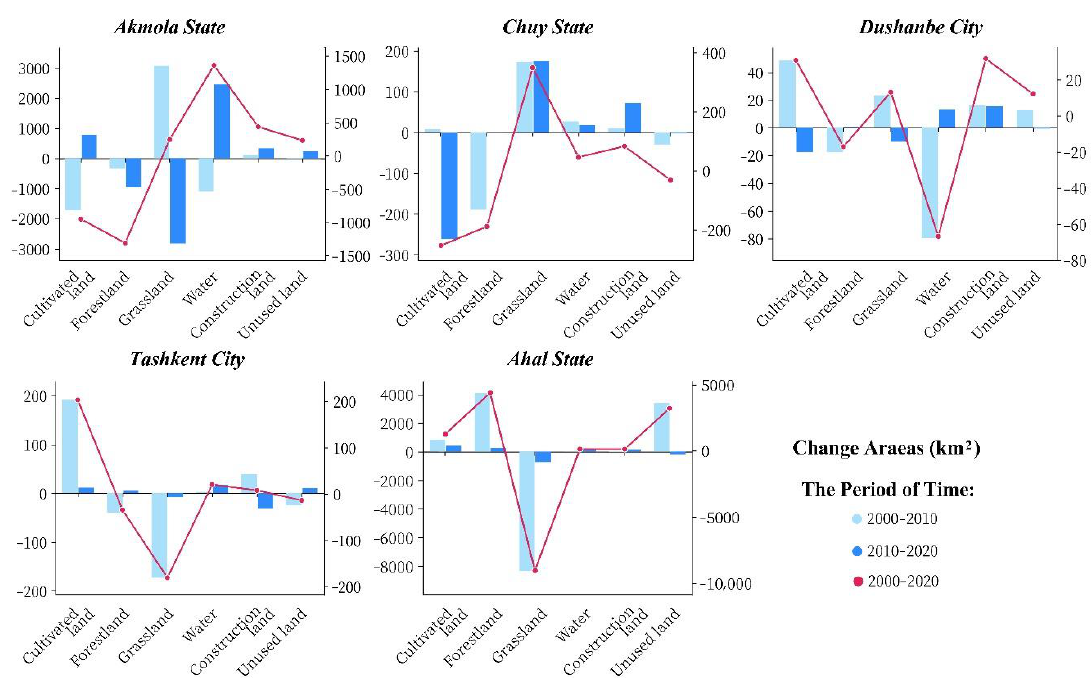
Figure 4. Change of land use area in different periods.